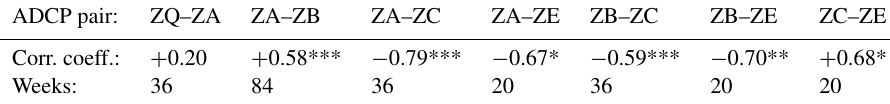
Table 1. Correlation coefficients between weekly averaged along-channel (eastward) velocities at ≈ 200m depth (for ZQ–ZA, ≈ 120m) at five ADCP sites on the Z-section during deployments in 2011–2012 and 2013–2014. “Weeks” indicates the number of values for each correlation.